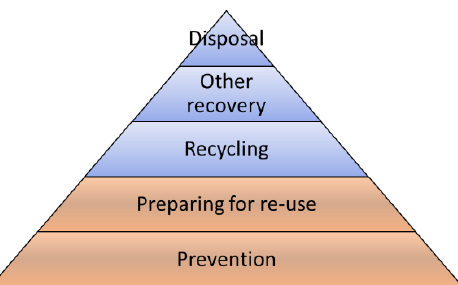
Figure 1. Waste management hierarchy according to Council Directive 1999/33/CE [17].